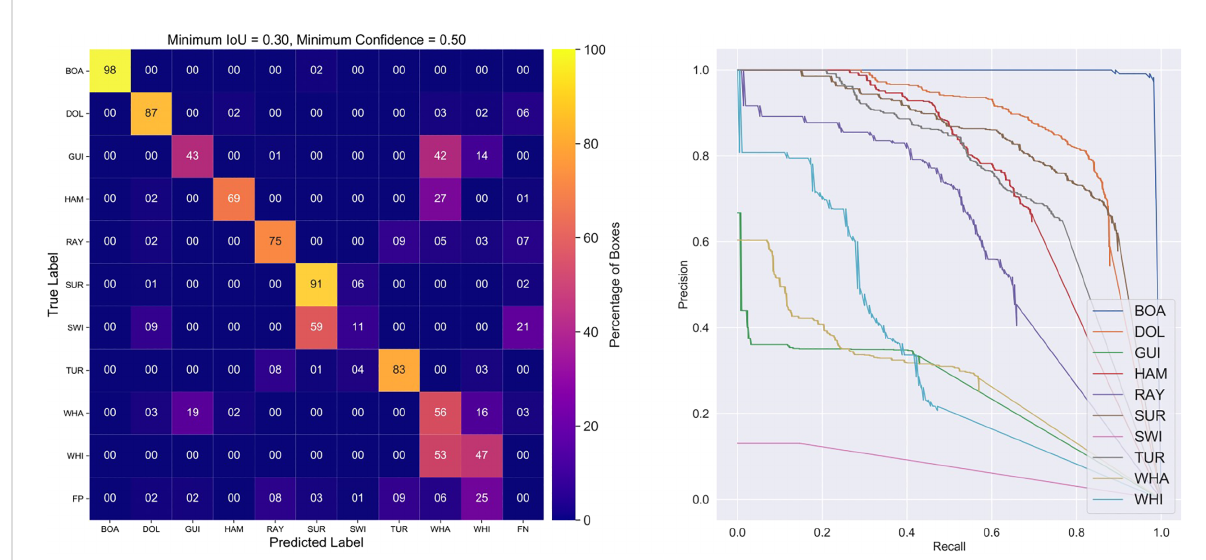
FIGURE 9 Confusion matrix (left) and precision-recall plot (right) for the fi nal ResNet-50 backbone model applied to the external testing dataset. The cross-matching IoU threshold was set at 0.3 and con fi dence score thresholds at 0.5 for optimum performance. The external data presents a harder and more realistic challenge compared to the internal data, as indicated by the mean average precision falling to mAP = 0.51. However, the performance is still reasonable when seeking to distinguish between sharks and other objects. Some general patterns are visible: swimmers are confused for surfers and white sharks for whalers over half of the time. Guitar fi sh are misidenti fi ed as whaler sharks 42% of the time, but much less often the other way around (19%). Hammerheads are also sometimes confused as whalers, and swimmers are occasionally not detected (21%). Analysis reveals that most of these issues are explained by biases in the training data, or systematic differences compared to the testing